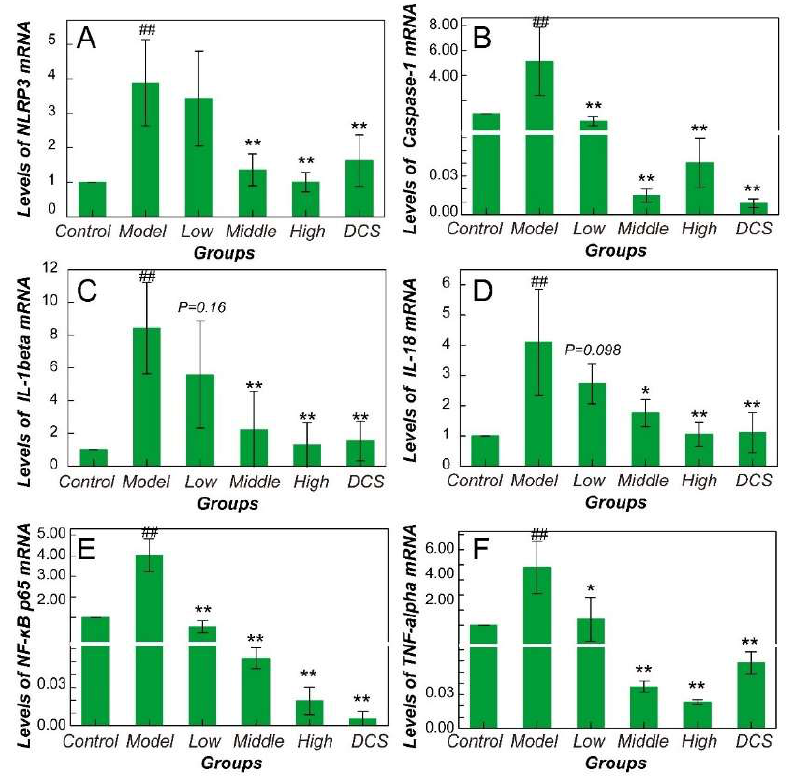
Figure 2. Quantification results of real-time PCR in all murine groups. Gene expression level of ( A ) NLRP3, ( B ) caspase-1, ( C ) IL-1β, ( D ) IL-18, ( E ) NF-κB p65, ( F ) TNF-α. All values were normalized against β-actin. DCS, Diclofenac sodium. ## p < 0.01 vs. Control. * p < 0.05 vs. Model. ** p < 0.01 vs. Model.